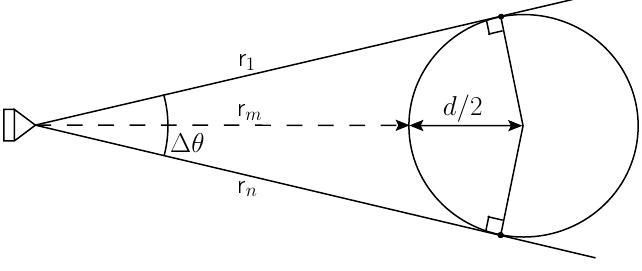
Figure 2. Tree trunk diameter according to the TD algorithm using two right-angled triangles and the center point for the detected